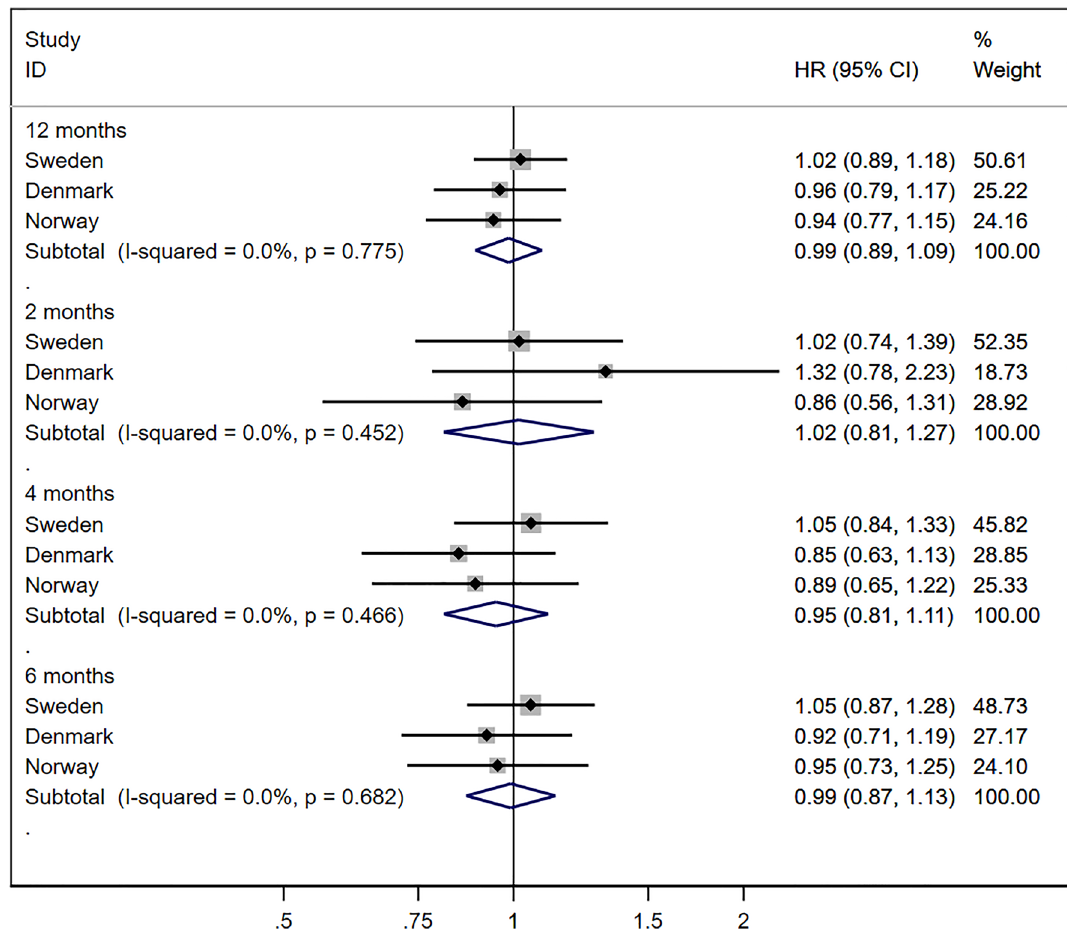
Figure 4. Estimates of the change in stillbirth in Sweden, Denmark and Norway after March 12th, 2020. The hazard ratios are adjusted for calendar week at